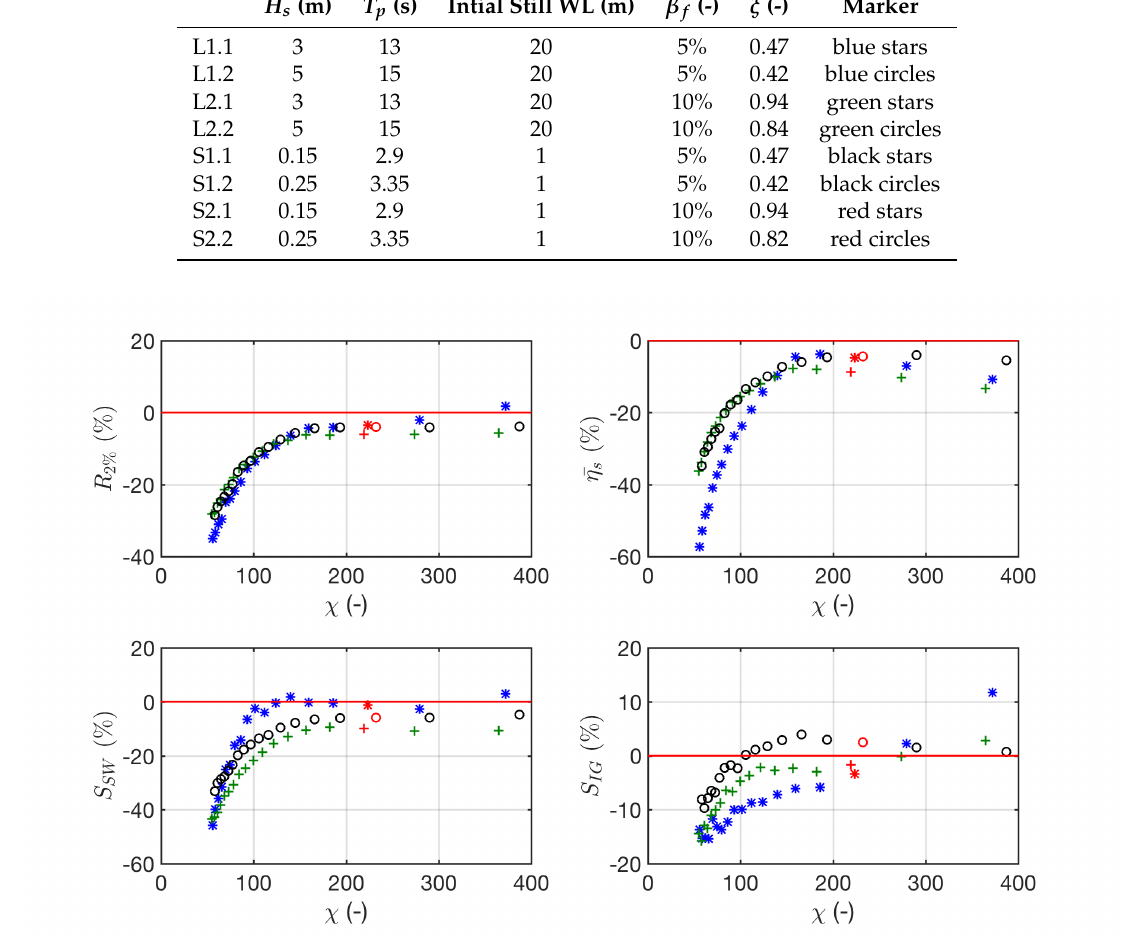
Figure 9. Relative error of the runup components between the numerical results and the laboratory experiment in function χ for case DR0 (blue stars), SBE2 (green plus signs), and SBA1 (black circles). The corresponding χ to dx = 0.5 m is shown in red. Note that χ increases for decreasing values of dx